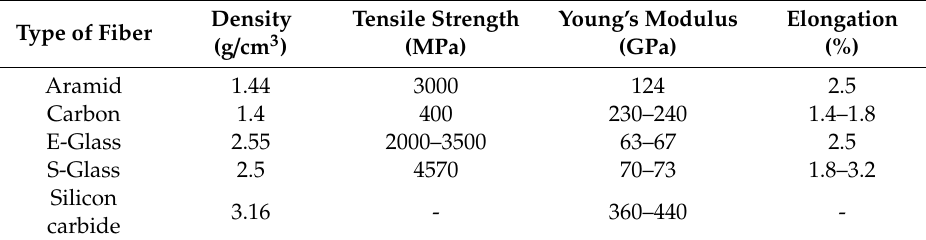
Table 4. Mechanical properties of synthetic fibers [26–28].